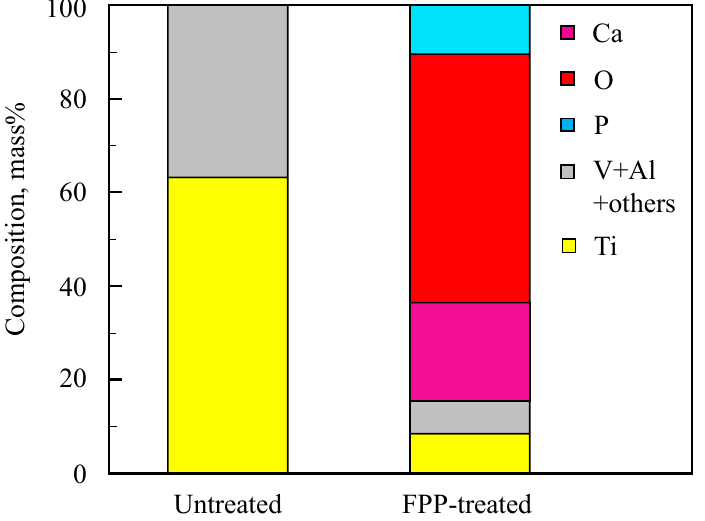
Figure 4. Elemental composition of untreated and FPP-treated specimen surface determined by EDS analysis.